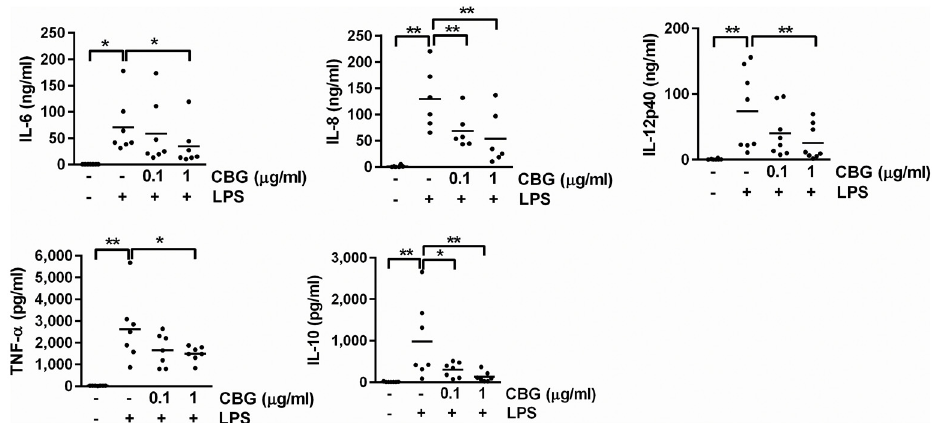
Fig 2. Inhibited cytokine release of LPS-stimulated DCs. DCs were stimulated with LPS (100 ng/ml) in the presence of vehicle or CBG for 24 hours. Supernatants were collected and analyzed for IL-6, IL-8, IL-12p40, TNF- α and IL-10. Data shown represent cytokine production for each donor and mean values for 6 – 8 donors. * P < 0.05. ** P < 0.01.